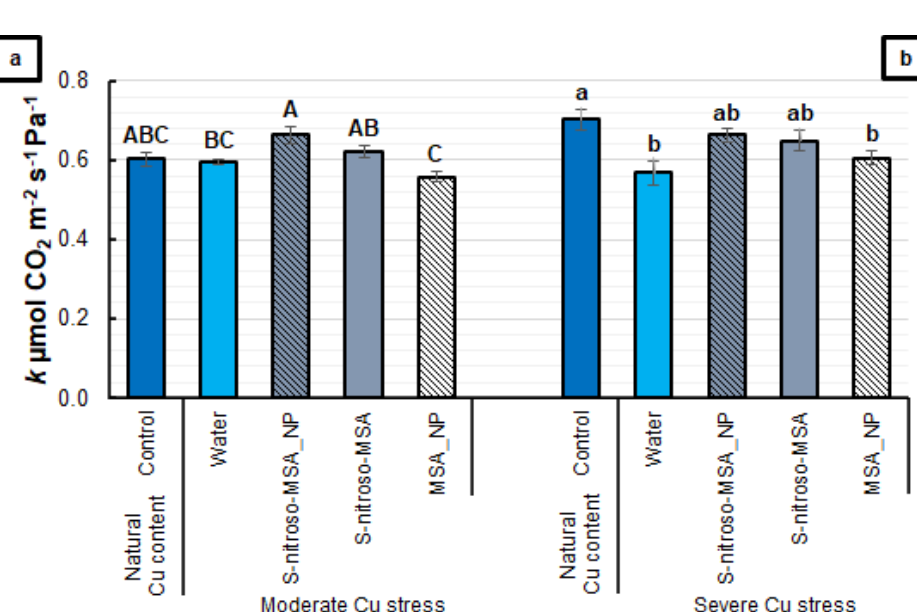
Figure 5. Instantaneous carboxylation efficiency ( k ) ( a , b ) of soybean plants cultivated in soil con- taining different copper (Cu) levels (natural content: 11 mg kg − 1 ; moderate Cu stress: 164 mg kg − 1 ; severe Cu stress: 244 mg kg − 1 ). Control = treatment with distilled water; water = treatment with distilled water after Cu addition; S-nitroso-MSA_NP = treatment with a nanoencapsulated NO donor (S-nitroso-mercaptosuccinic acid) at 1 mM; S-nitroso-MSA = treatment with a NO donor (S-nitroso- mercaptosuccinic acid) in the free form at 1 mM; MSA_NP = treatment with nanoparticles containing the non-nitrosated MSA at 1 mM. Data are the mean ± standard error ( n = 8). The same uppercase and lowercase letters on the column (referring to experiments 1 and 2, respectively) indicate values that do not differ by ANOVA, followed by the Tukey test ( p < 0.05).